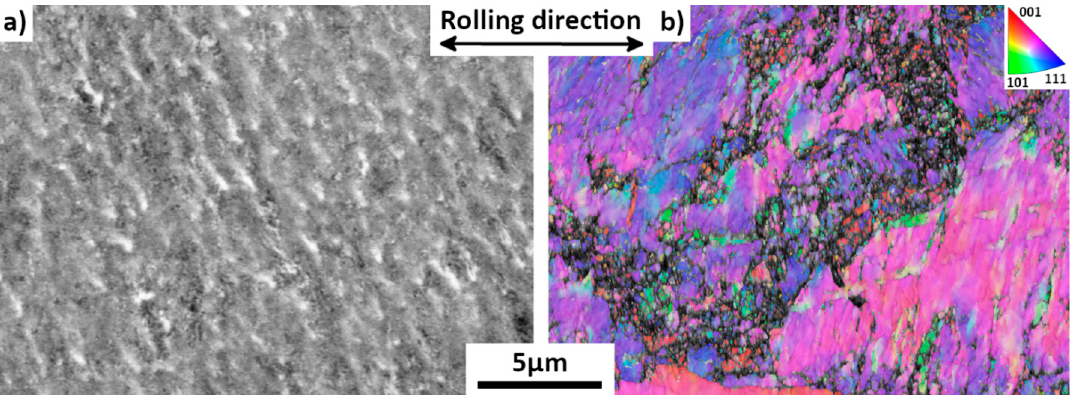
Figure 8. Un-annealed 85%-rolled sample. ( a ) BSE map. ( b ) EBSD IPF (//rolling direction) map (step size 30 nm).